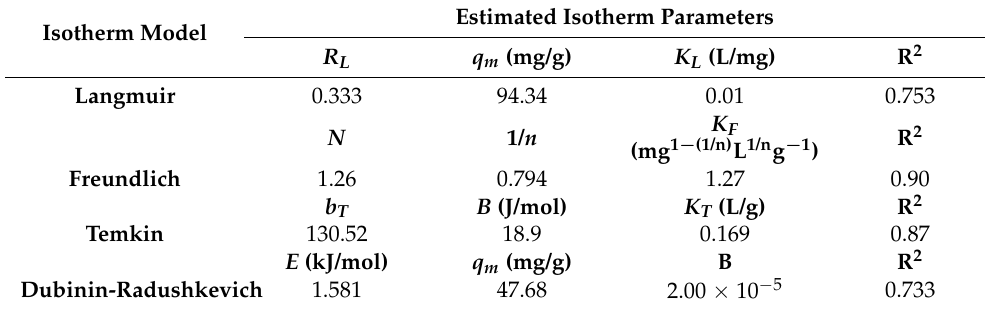
Table 1. Langmuir, Freundlich, Temkin, and Dubinin–Radushkevich constants calculated from linear isotherms at pH 6. Isotherm